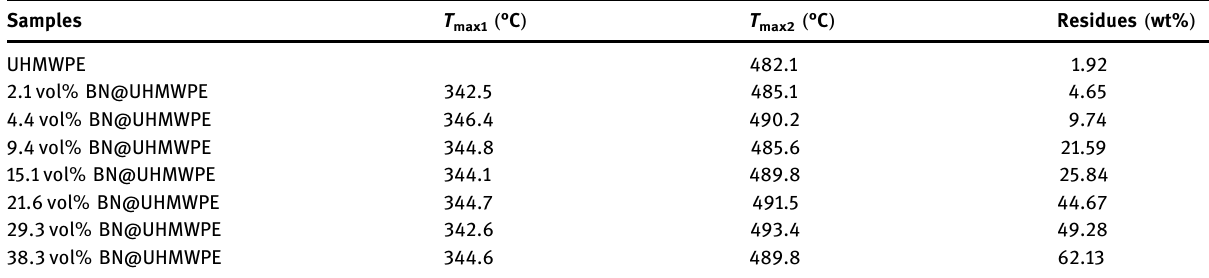
Table 2: TGA parameters of BN@UHMWPE composites